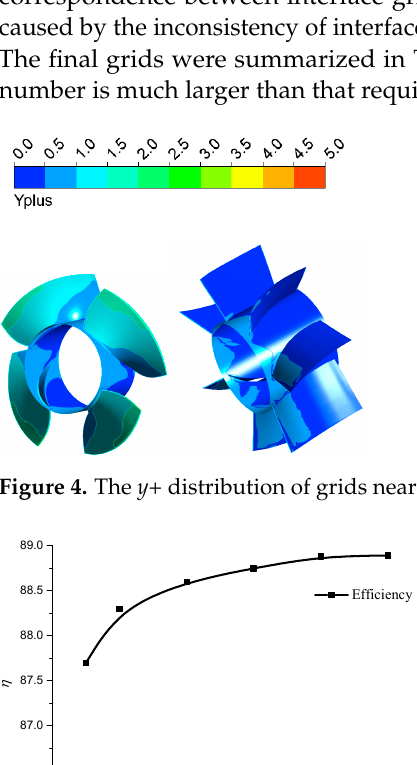
Figure 3. Boundary layer wall ratio.